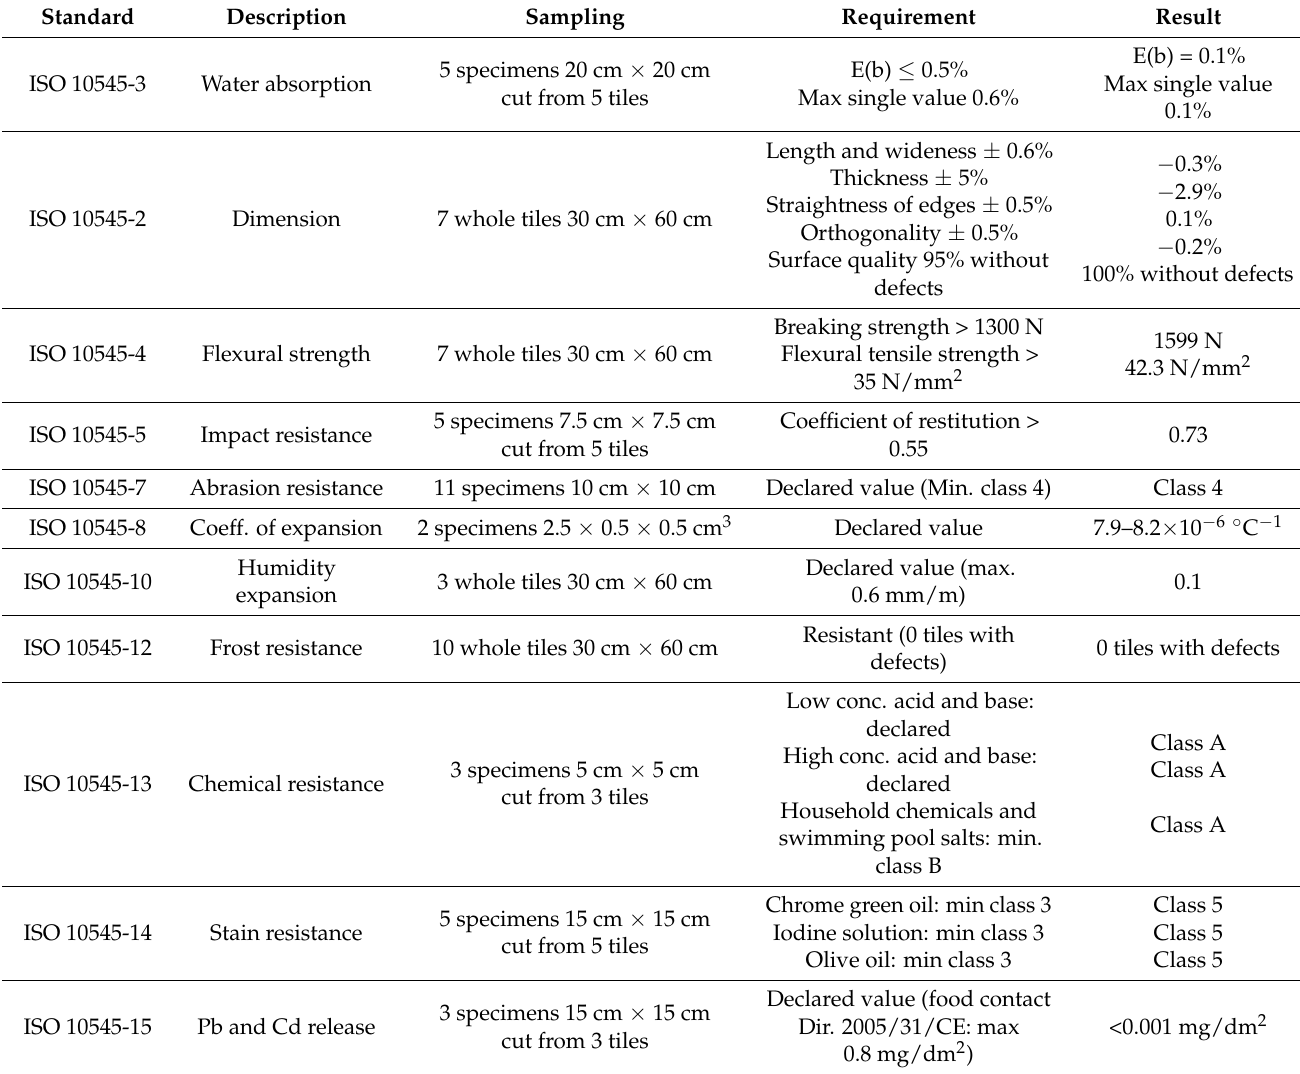
Table 5. Technical performances of 85% HRC porcelain stoneware tiles produced on an industrial